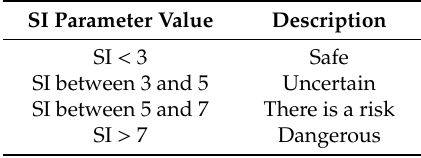
Table 5. Interpretation of results for the Moore and Garg module.